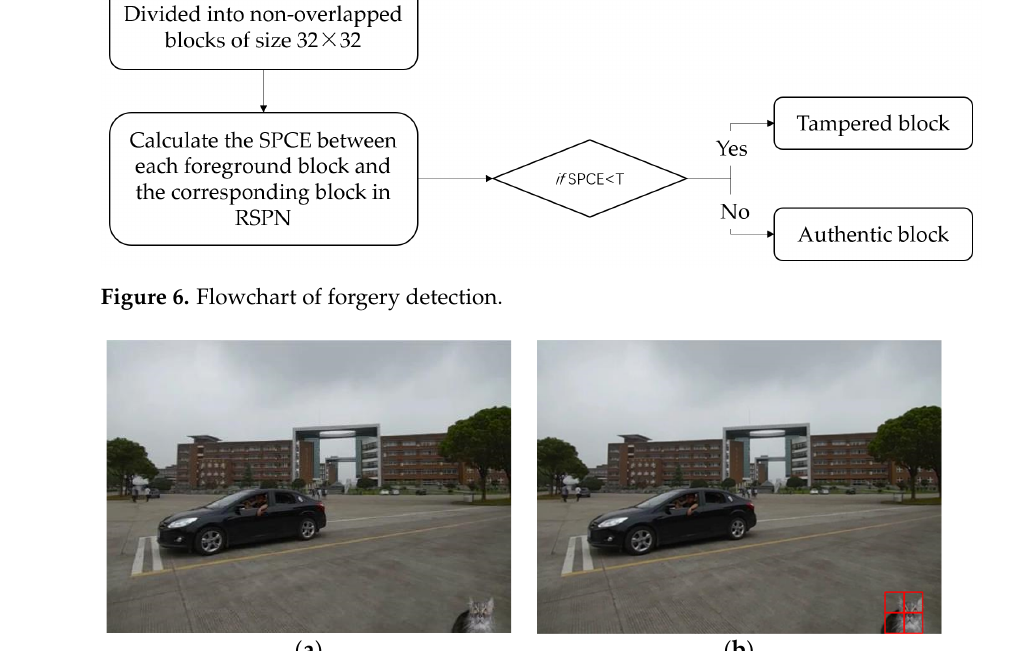
Figure 6. Flowchart of forgery detection.